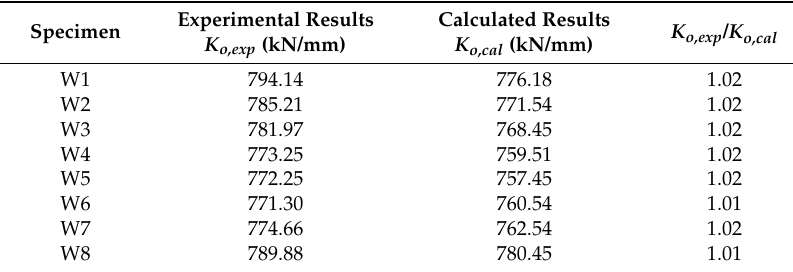
Table 9. Experimental and calculated results of initial stiffness.